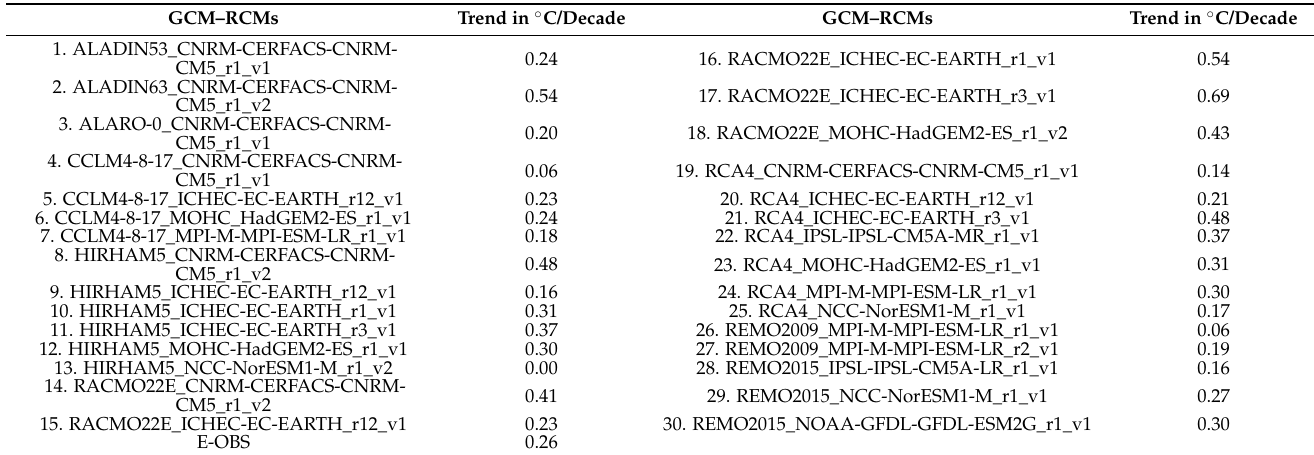
Table 2. Temperature trends averaged over the Pannonian Basin of the EURO-CORDEX RCMs and E-OBS during the 1970–2005